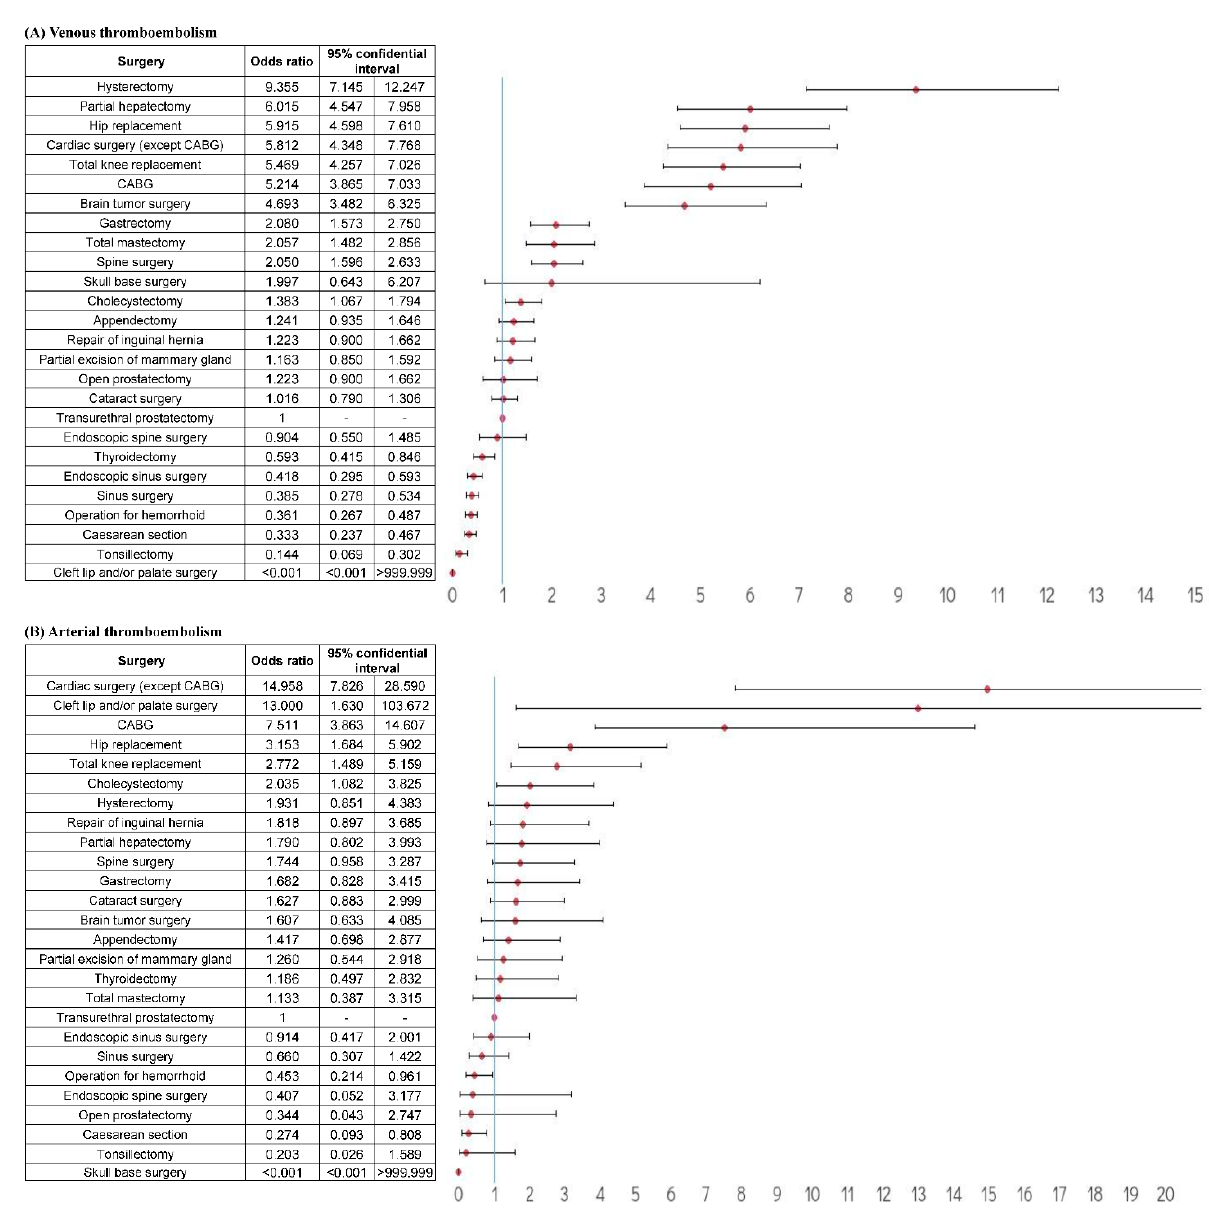
Figure 3. Odds ratios of thromboembolism events with anticoagulant treatment for each type of surgery after correcting for thromboembolism risk factors. Abbreviation: CABG, coronary artery bypass graft. ( A ) venous thromboembolism events with anticoagulant treatment ( B ) arterial thromboembolism events with anticoagulant treatment.